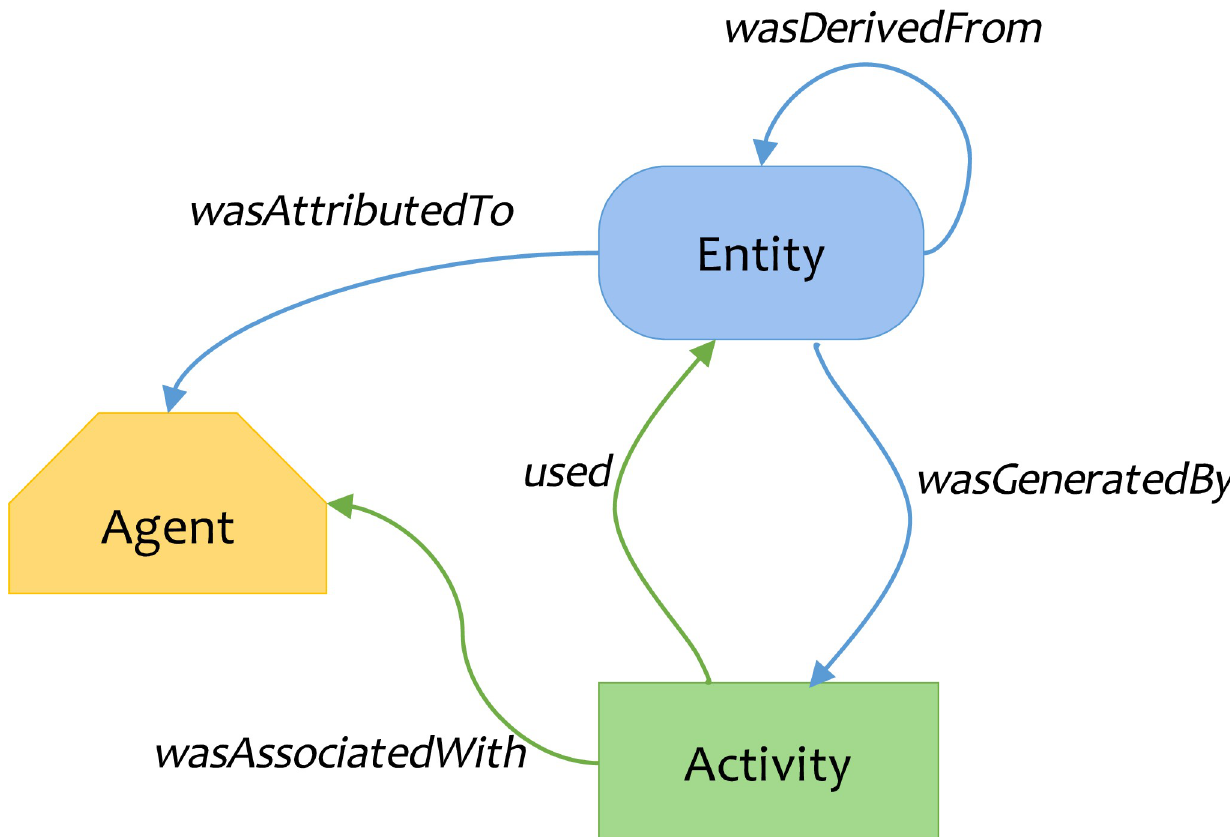
Fig 2. W3C PROV data model overview, used in Fast Healthcare Interoperability Research (FHIR) and research object (RO). Adapted from http:// www.w3.org/TR/prov-primer/.